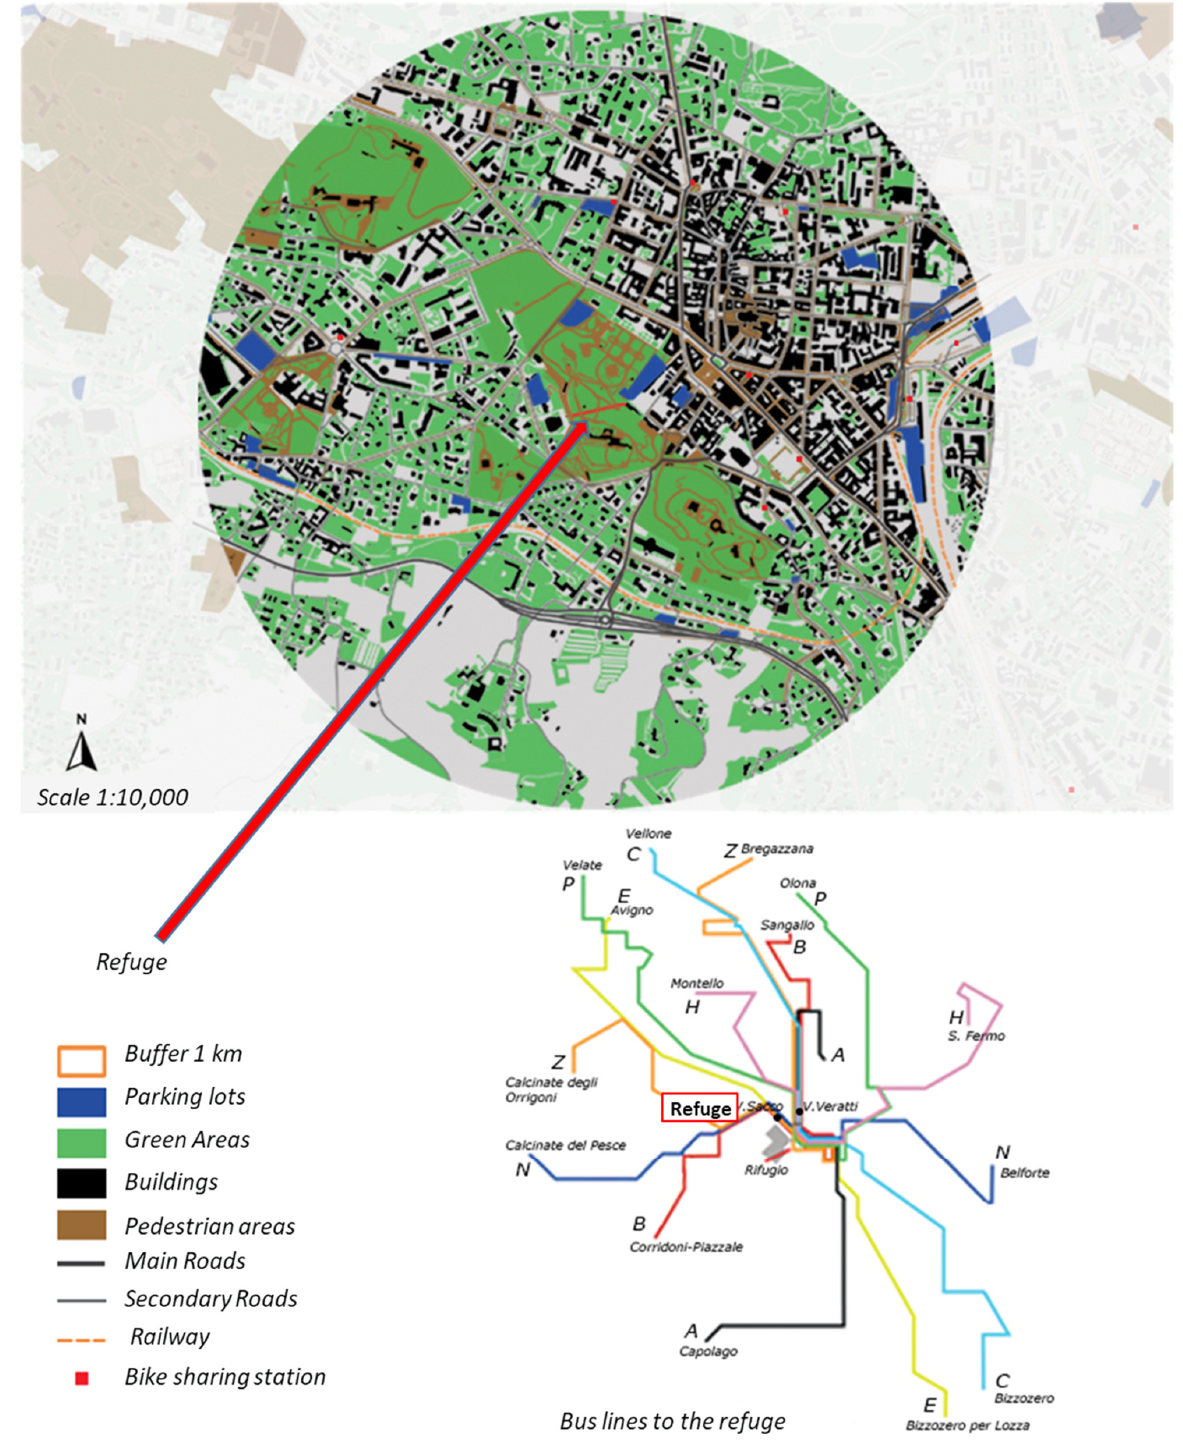
Figure 7. Representation of the area where the air-raid shelter is located with visualization of the points of access to bike-sharing stations, available roads, and the public transportation system. Elaboration by A.